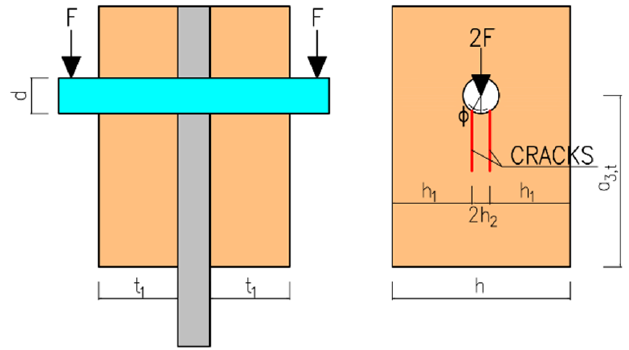
Figure 5. Position of the assumed cracks under the fastener (see also Formula (10)).